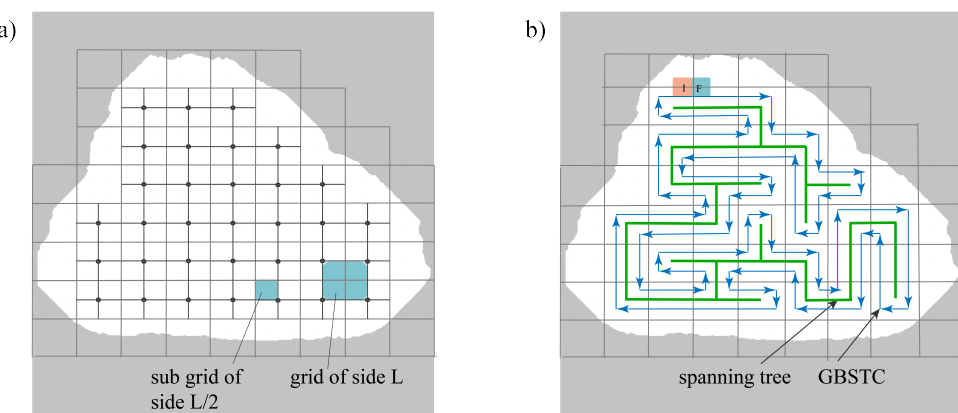
Figure 3. ( a ) Approximate cell decomposition in grids, and sub grids. ( b ), coverage path generated with the GBSTC method.